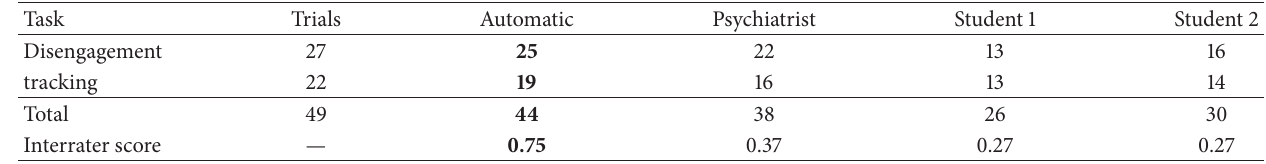
Table 4: Number of agreements with the autism expert for each participant in the two visual attention tasks and overall interrater reliability using weighted Cohen’s kappa. See Tables 2 and